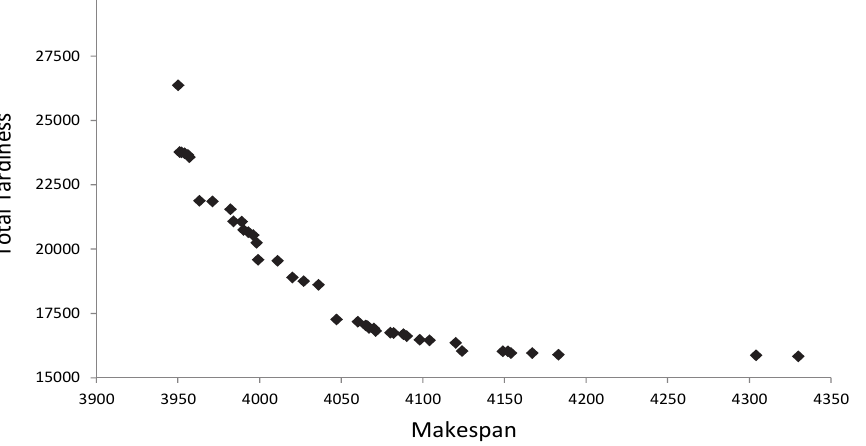
Fig. 3. Conflict between objectives - Objective function representation for scenario 3 of 50J_20M